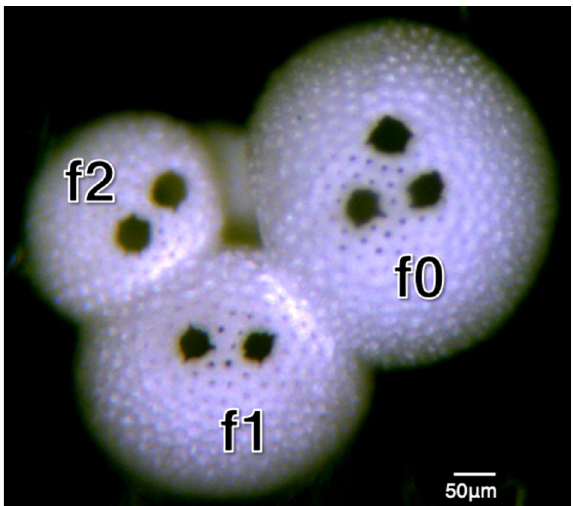
Figure 1. Specimen of T. sacculifer after LA-ICPMS showing growth chambers and laser ablation sites. The f0 chamber is the final growth chamber prior to formation of the final sac, f1 is the penultimate chamber, and f2 precedes it. Ablation targets are 50